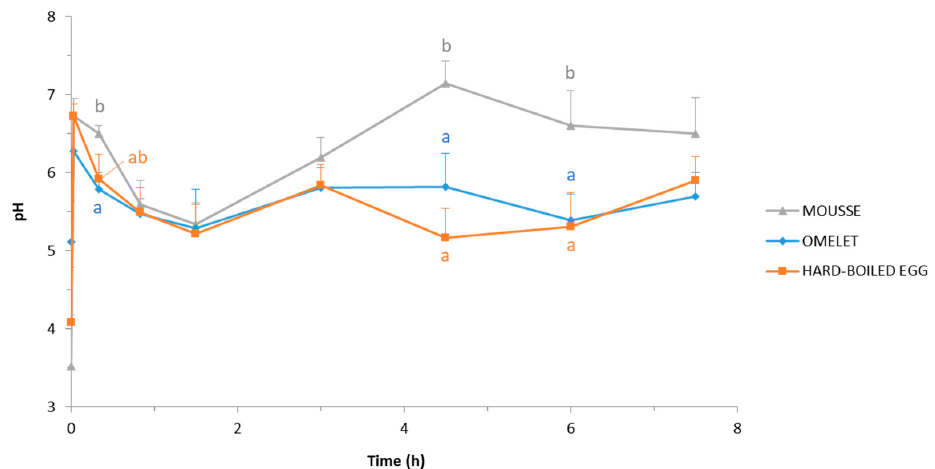
Figure 2. pH evolution of the duodenal effluents throughout 7.5 h postprandial after the ingestion of the DHA-enriched omelet, hard-boiled egg, and mousse. Means and SEM were calculated from n = 9 pigs. For a given digestion time, different letters display significantly different mean values ( p < 0.05).